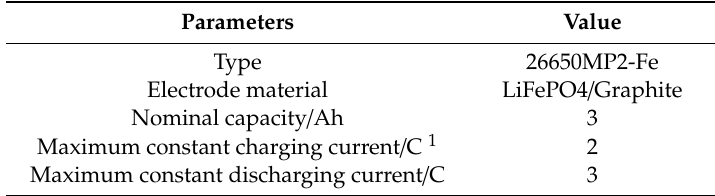
Table 1. Battery